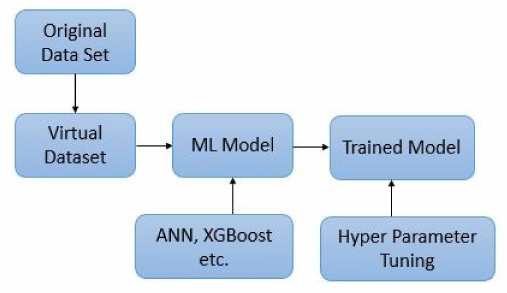
Figure 3. Training of